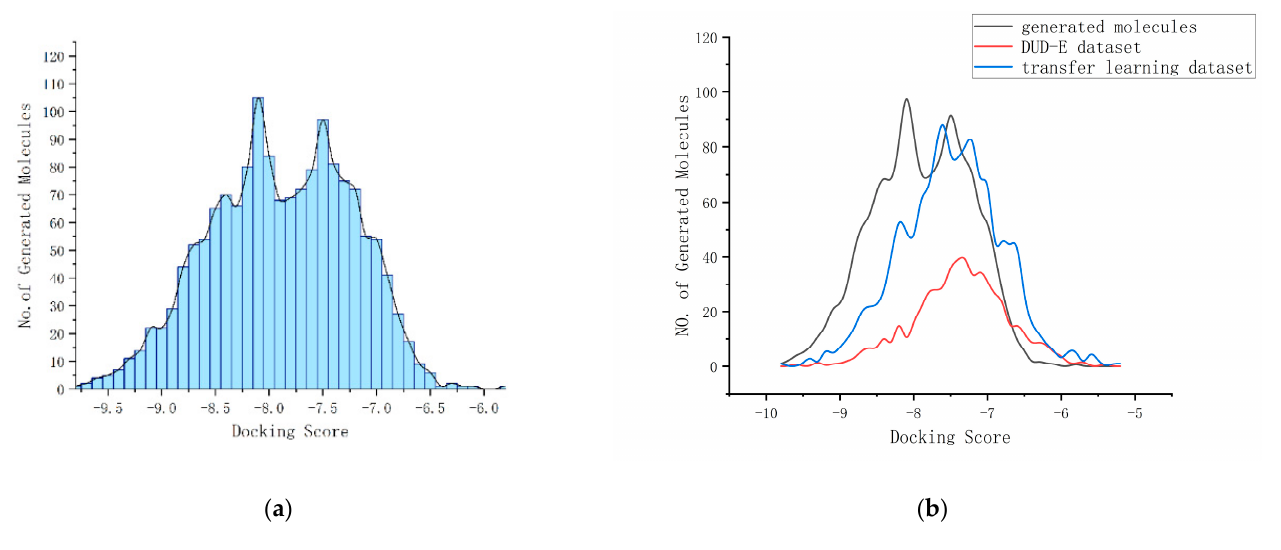
Figure 4. The distribution of docking scores. ( a ) The distribution of docking scores of the generated molecules; ( b ) the distribution of docking scores of the generated molecules and the transfer learn ‐ ing